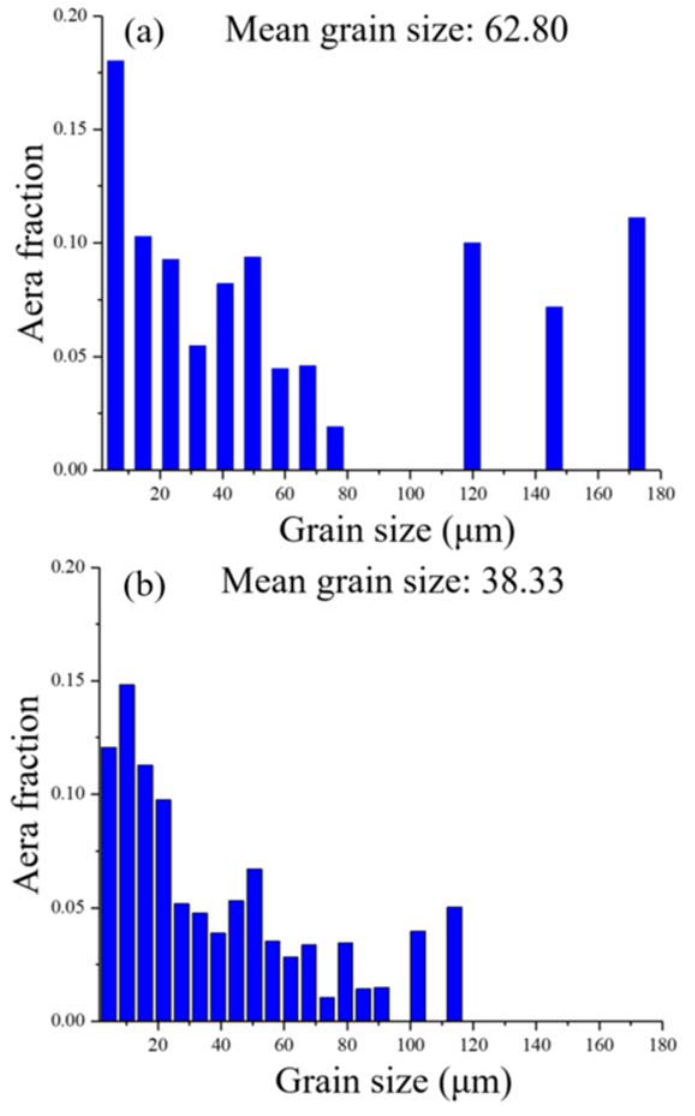
Figure 4. Grain size distributions of the LMD sample: ( a ) XY ‐ plane and ( b ) YZ ‐ plane. Figure 5a,b show the grain ‐ boundary ‐ length densities and cumulative grain ‐ boundary ‐ length densities of the XY ‐ and YZ ‐ plane samples in the corresponding misorientation angle range, respectively. The grain boundaries with both low misorientation angles (0–10°) and high misorientation angles (50–60°) have greater density in the two planes. Among them, the grain ‐ boundary density in the range of the high misorientation angle (50–60°) on the YZ ‐ plane is highest, which is related to the higher proportion of large grains on the YZ ‐ plane. These results show that the grain ‐ boundary density on the YZ ‐ plane is higher than that on the XY ‐ plane and is inversely proportional to the mean grain size. Since the XY ‐ plane has a higher proportion of large grains and a lower grain ‐ boundary density, its area of high grain ‐ boundary density will be significantly smaller than that of the YZ ‐ plane.